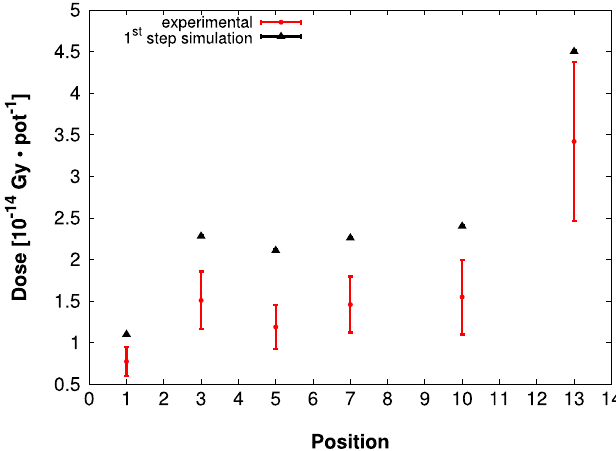
Fig. 3. Experimental and simulated doses at different test positions, cp_0000 target-shielding